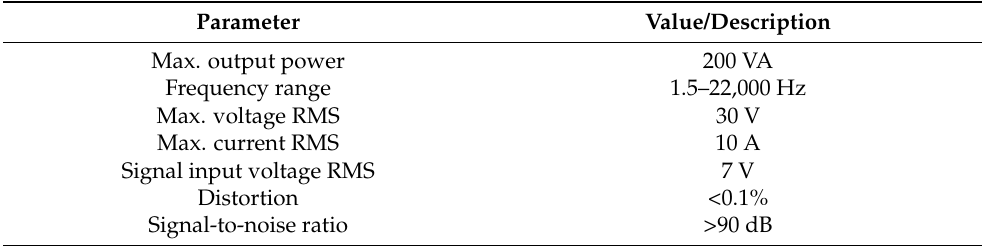
Table 3. Technical parameters of TIRA DA 200 digital